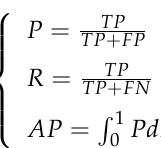
Figure 11. Measuring the pineapple eye error with a Vernier caliper. ( a ) W 1 measurement; ( b ) H 1 measurement; ( c ) W 2 measurement; ( d ) H 2